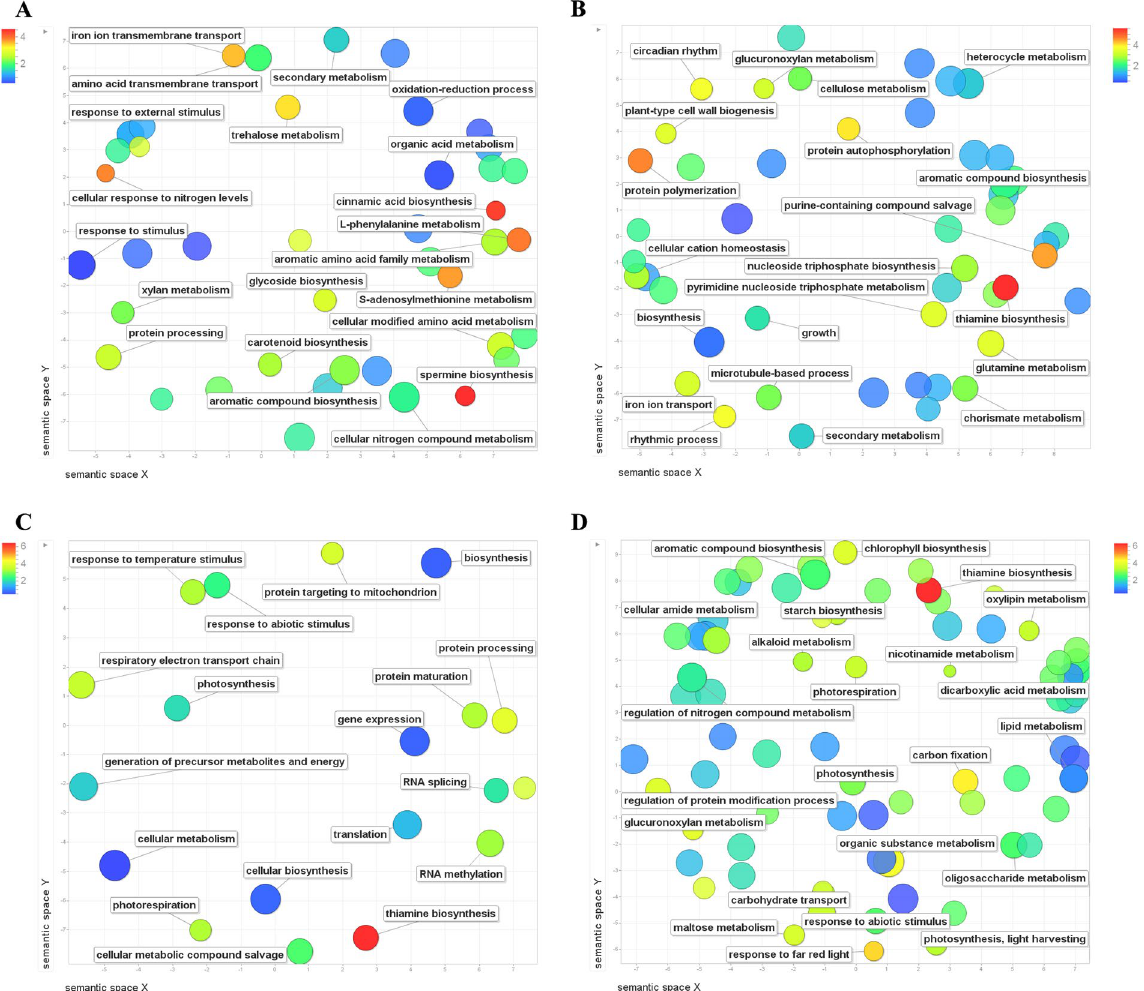
Figure 4. REVIGO semantic diagram summarizing enriched GO terms for roots ( A ), leaves/stems ( B ), flag leaf ( C ), and spike ( D ). Similar GO terms are placed close together in the plot. Bubble color indicates the log2 of the enrichment value for each category; circle size indicates the frequency of the GO term in GO